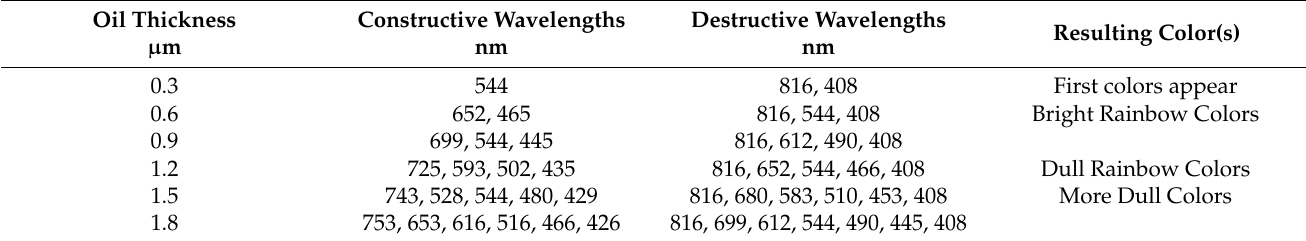
Table 2. Typical wave lengths resulting from interference